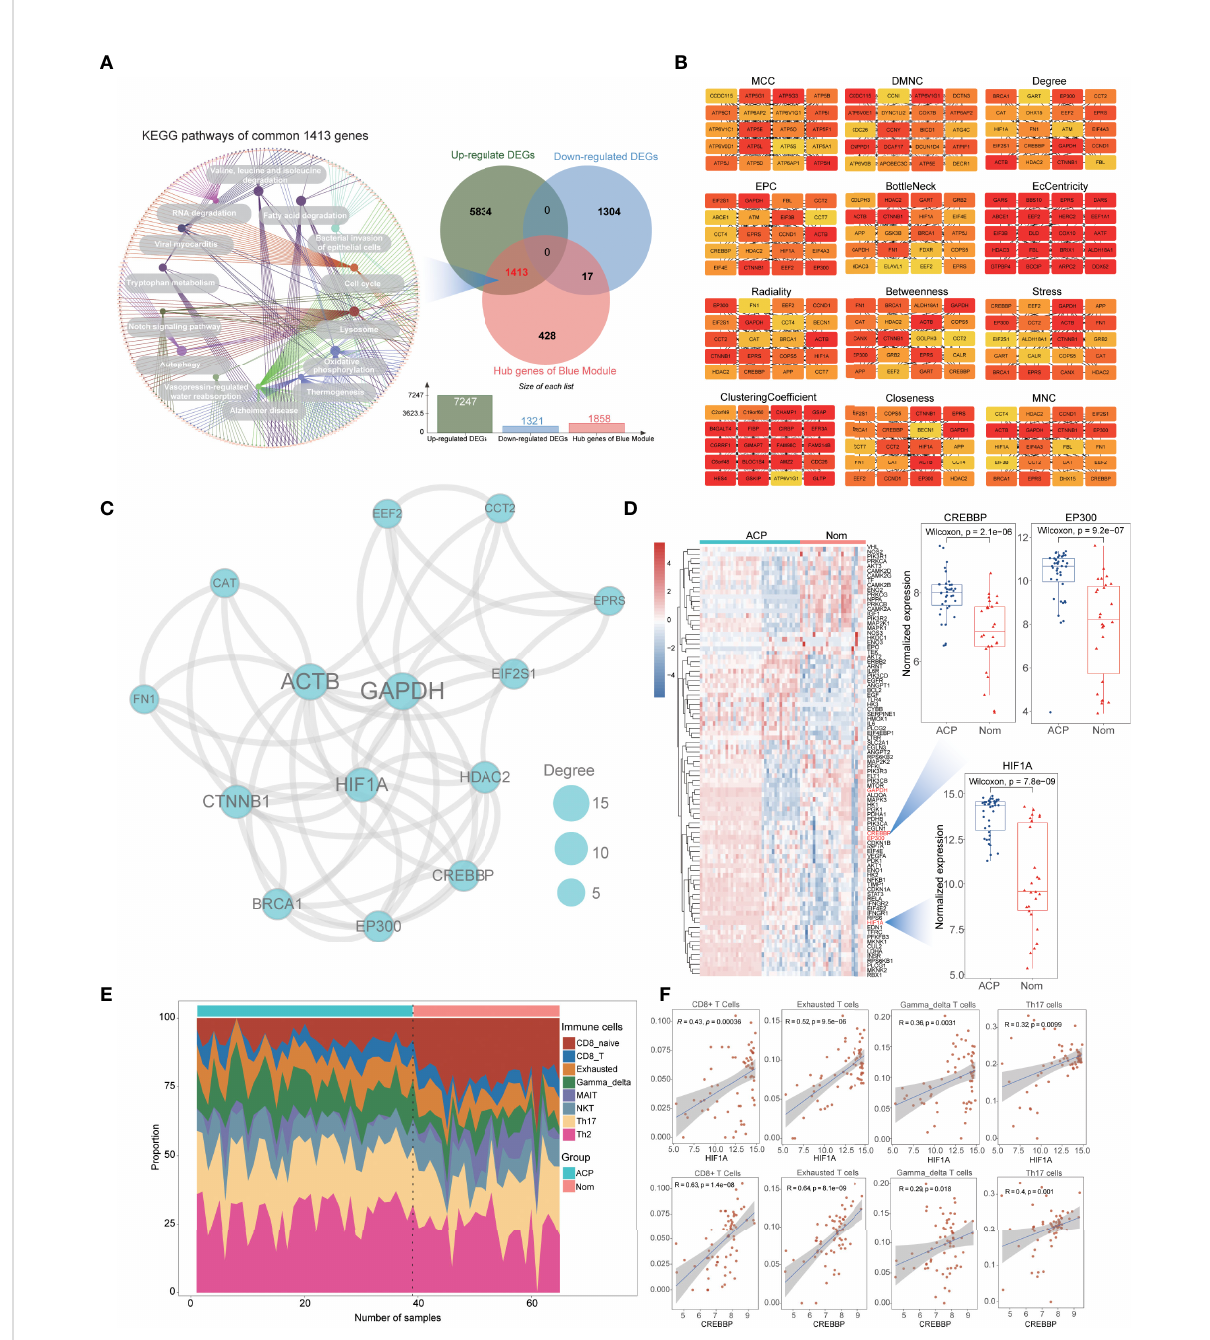
FIGURE 3 Identi fi cation of vital genes and immune cell in fi ltration (ICI) analysis for ACPs. (A) . Combined with previous DEGs and blue-module genes, the Venn plot showing common 1,413 upregulated hub genes and KEGG enrichment analysis indicated that they were signi fi cantly enriched in biological processes associated with energy metabolism regulation including fatty acid degradation, tryptophan metabolism, the Notch signaling pathway, autophagy, and oxidative phosphorylation. (B) . The top 20 genes from the PPI network with 12 algorithms using the Cytohubba plug- in. (C) . The protein – protein interaction (PPI) network of the HIF-1 a signaling pathway using hub genes. The nodes represent the degree value. (D) . The heatmap showing the different expression of genes from all the HIF-1 a signaling pathways between ACP and control cohorts and three essential genes (HIF-1 a , CREBBP, and EP300) were signi fi cantly increased in ACP patients. (E) . ICI analysis revealed that naïve CD4+ and CD8+ T cells were signi fi cantly decreased while speci fi c subtypes of T cells were signi fi cantly activated in ACP patients including gamma – delta T cells, NK T cells, and Th17 and Th2 cells. (F) . Correlational analysis displayed a signi fi cantly positive association between speci fi c T cells and HIF-1 a or